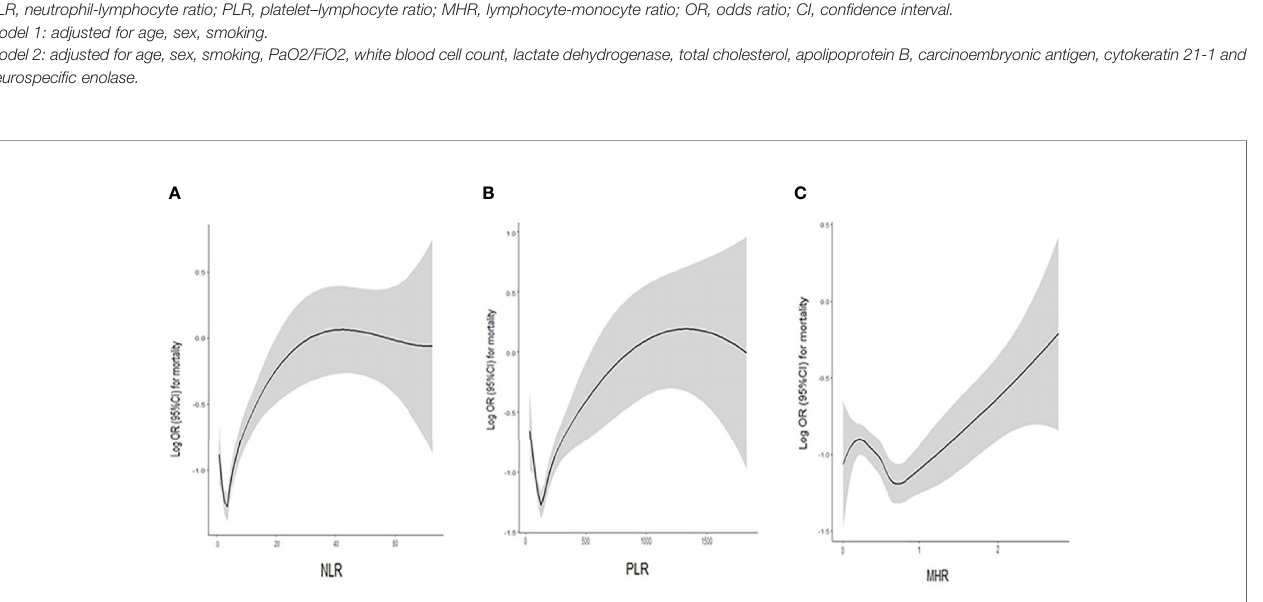
FIGURE 3 | A smooth curve fi tting for the relationship between the baseline NLR, PLR, MHR and the log odds ratio of mortality: (A) An inverse U-shaped relationship between NLR and mortality; (B) An inverse U-shaped relationship between PLR and mortality; (C) An U-shaped relationship between MHR and